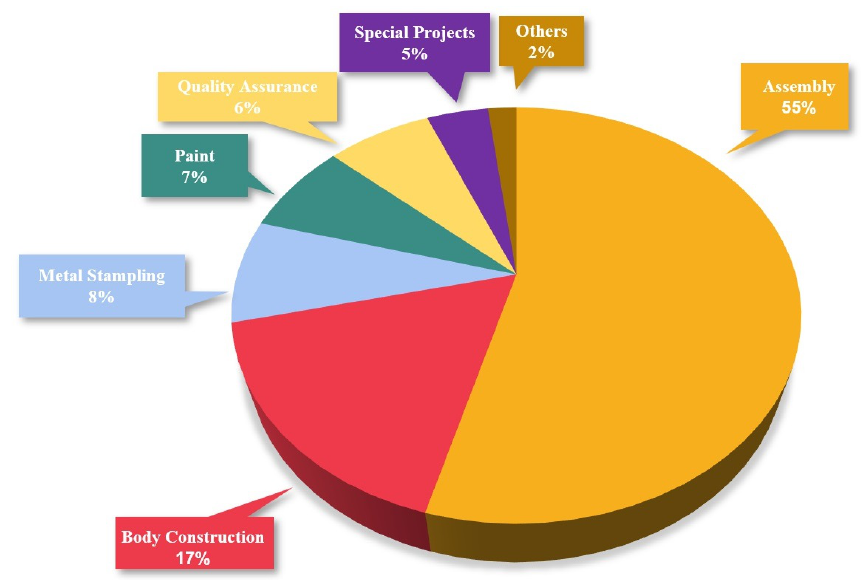
Figure 3. Distribution of workstations in OHPP records between 2019 to 2021 (>7k